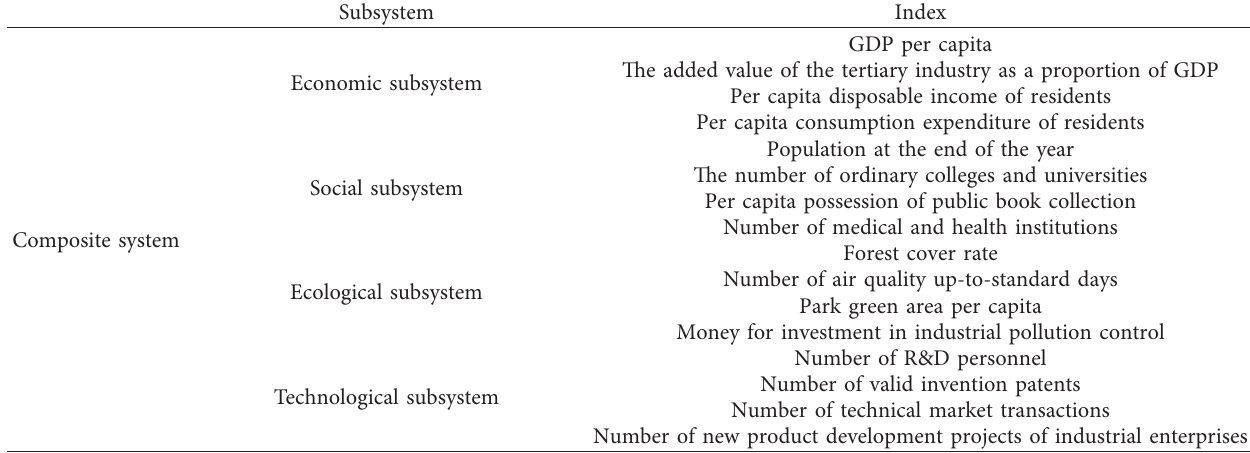
Table 2: Index system of the composite system.